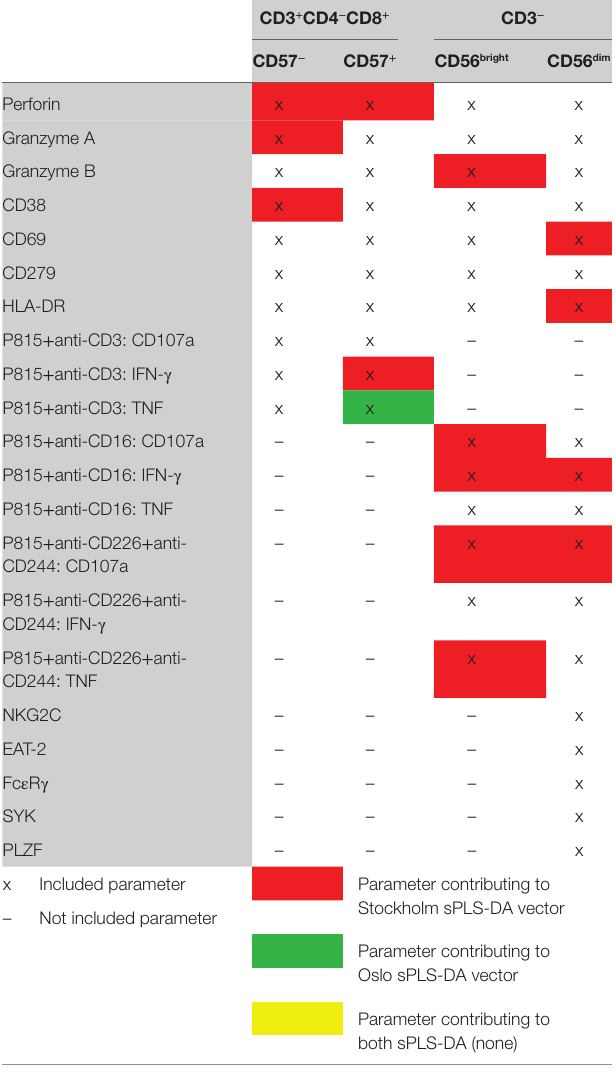
Table 2 | Parameters common to the Stockholm and Oslo substudies used for identification of patient/control discriminators.